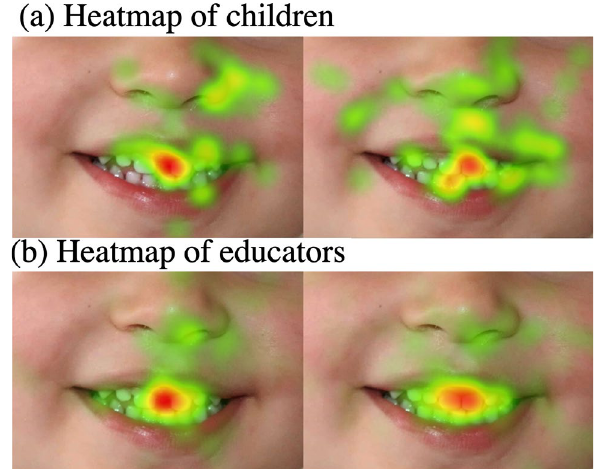
Figure 4. Heatmaps illustrating the areas of fixation for ( a ) children ( b ) educators when they viewed images with and without diastema. Note area in red indicates the maximum focus, which is predominantly on teeth for both